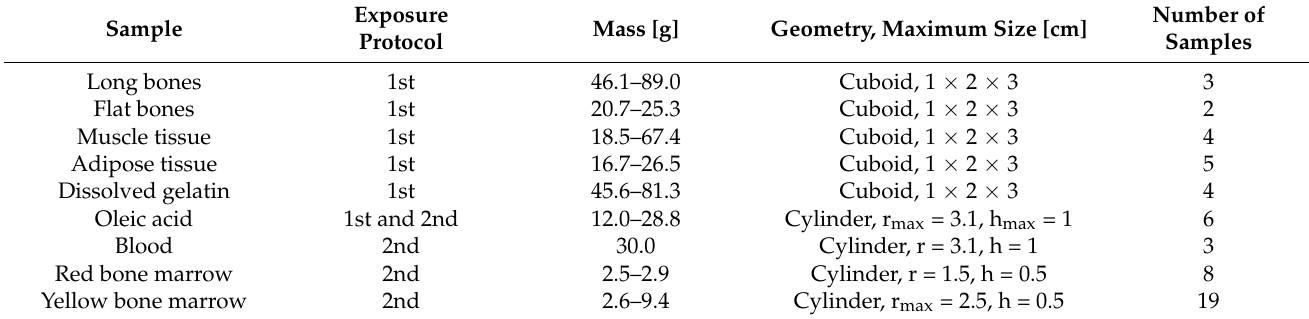
Table 1. Exposure details of different samples including the used exposure protocol, the range of the sample’s mass, its geometry and the number of samples. The cubic geometry is characterized by the height, width and length, and the cylinders by their maximum radius (r max ) and maximum height (h max